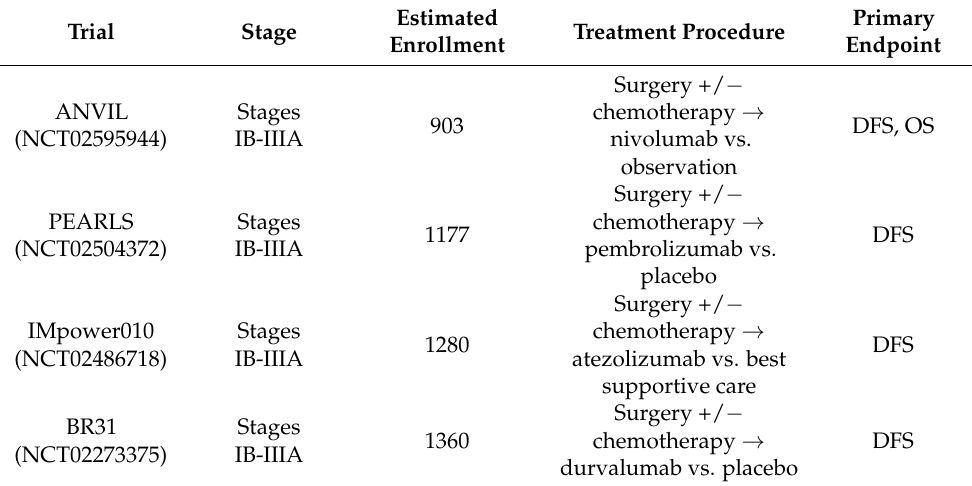
Table 4. Ongoing clinical trials using ICIs as adjuvant therapy for post-surgery NSCLC